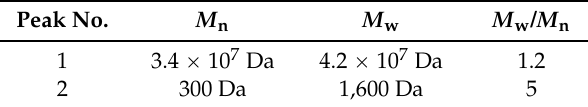
Figure A1. Structural units of hPES 1 . Table A1. Molecular weight distribution of hPES 1 .